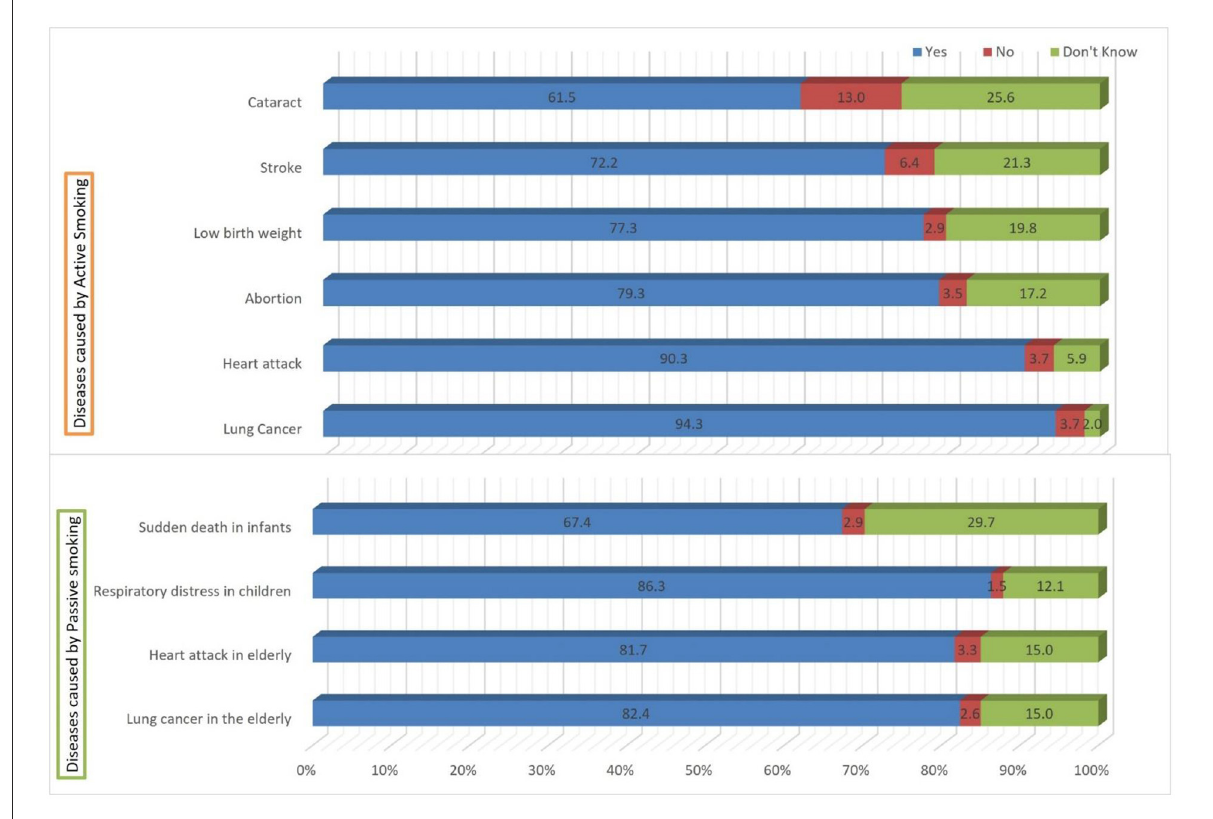
FIGURE3 Student’s belief about the diseases caused by active and passive smoking.